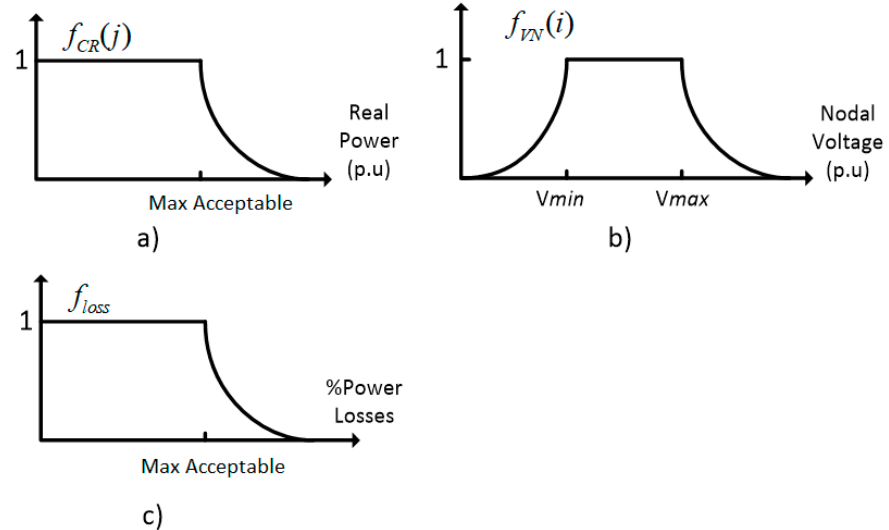
Figure 4. Sub-functions for: ( a ) voltages in load buses, ( b ) power flows in lines and ( c ) active power losses.